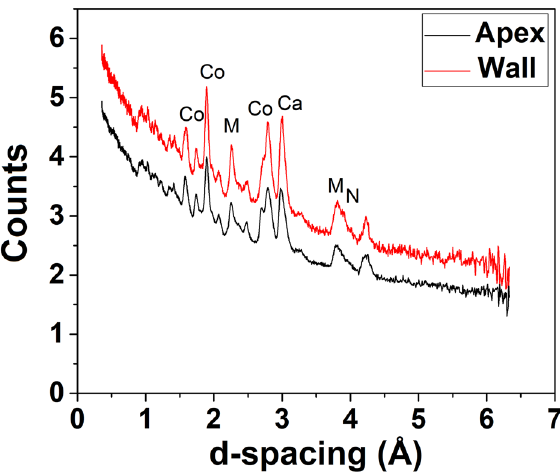
Figure 5. Two representative neutron diffraction patterns of helmet 2 ( Co Covellite, Ca Calcite, N Nantokite, M